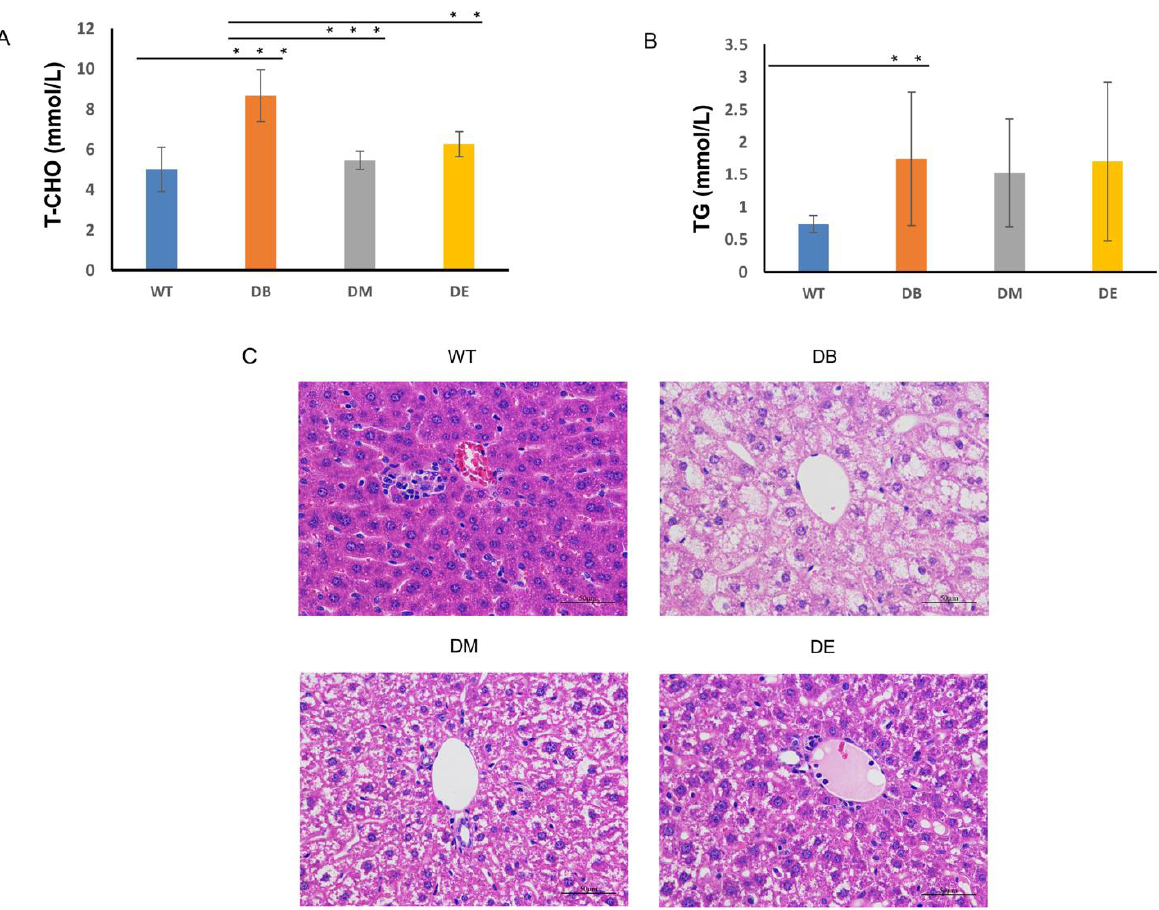
Figure 2. Exercise decreases diabetes-induced hypercholesterolemia. ( A ) T-CHO levels in serum from WT, DB, DM, and DE mice. ** p < 0.01 and *** p < 0.001, n = 6. ( B ) TG levels in serum from WT, DB, DM, and DE mice. ** p < 0.01, n = 6. ( C ) HE staining images of livers from WT, DB, DM, and DE mice ( n = 3).